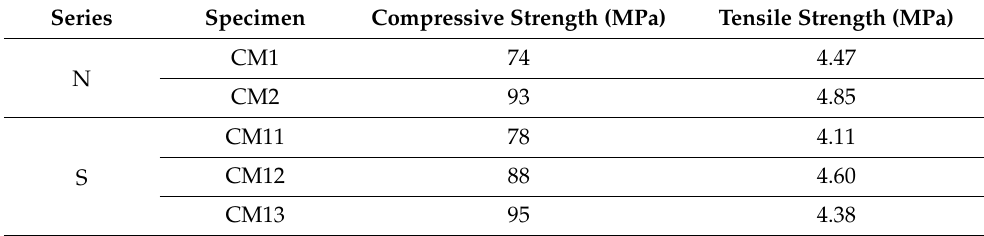
Table 3. Material characteristics of